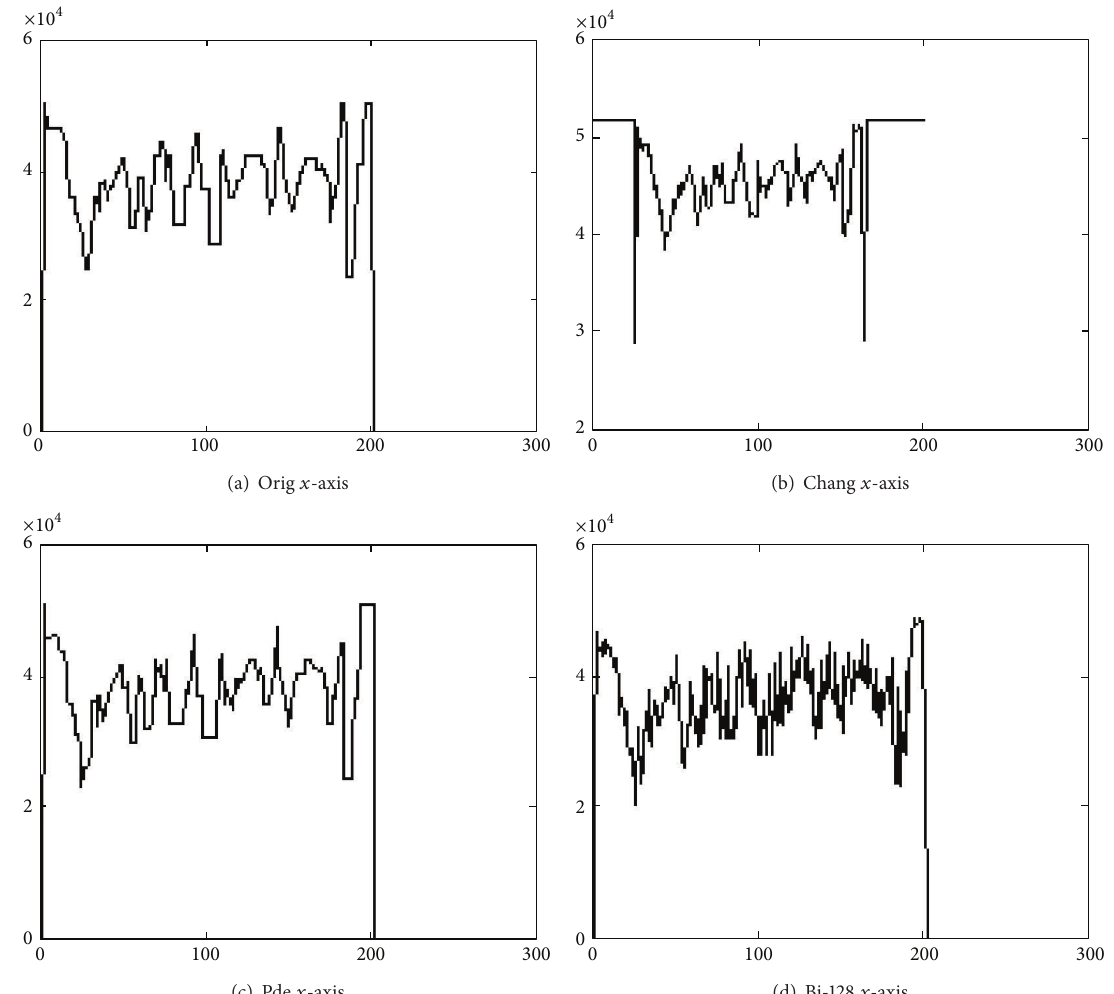
Figure 9: Comparison in Experiment 1: projection of images to the 𝑥 -axis: (a) original image, (b) distorted image, (c) restored image by IEWC, and (d) restored image by the piecewise bilinear